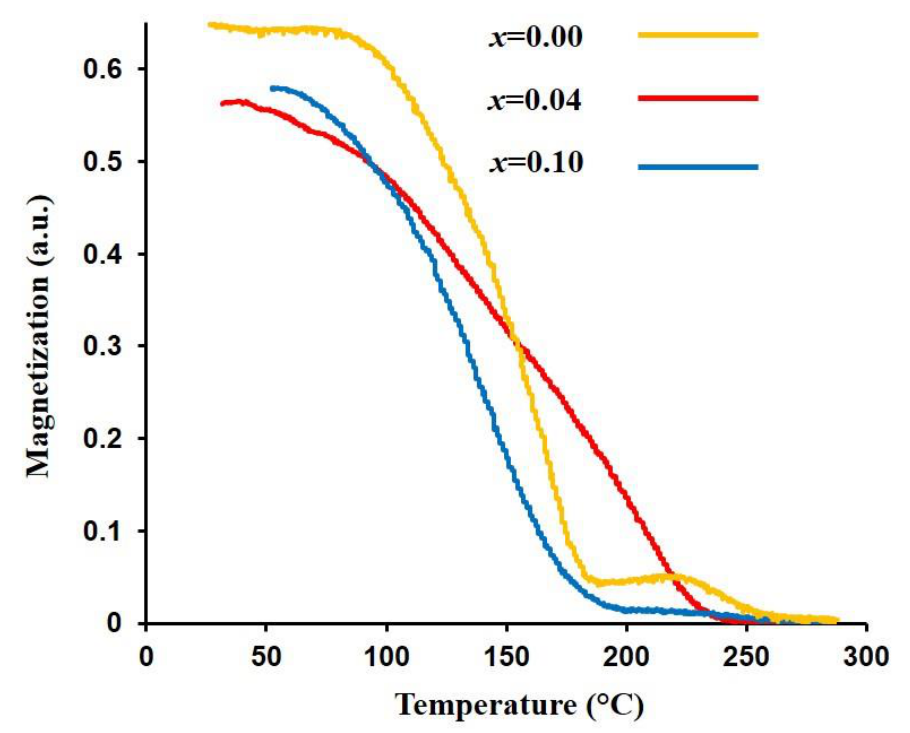
Figure 7. M-T curves for Mn 0.6 Zn 0.4 Eu x Fe 2 − x O 4 ( x = 0, 0.04, and 0.1).